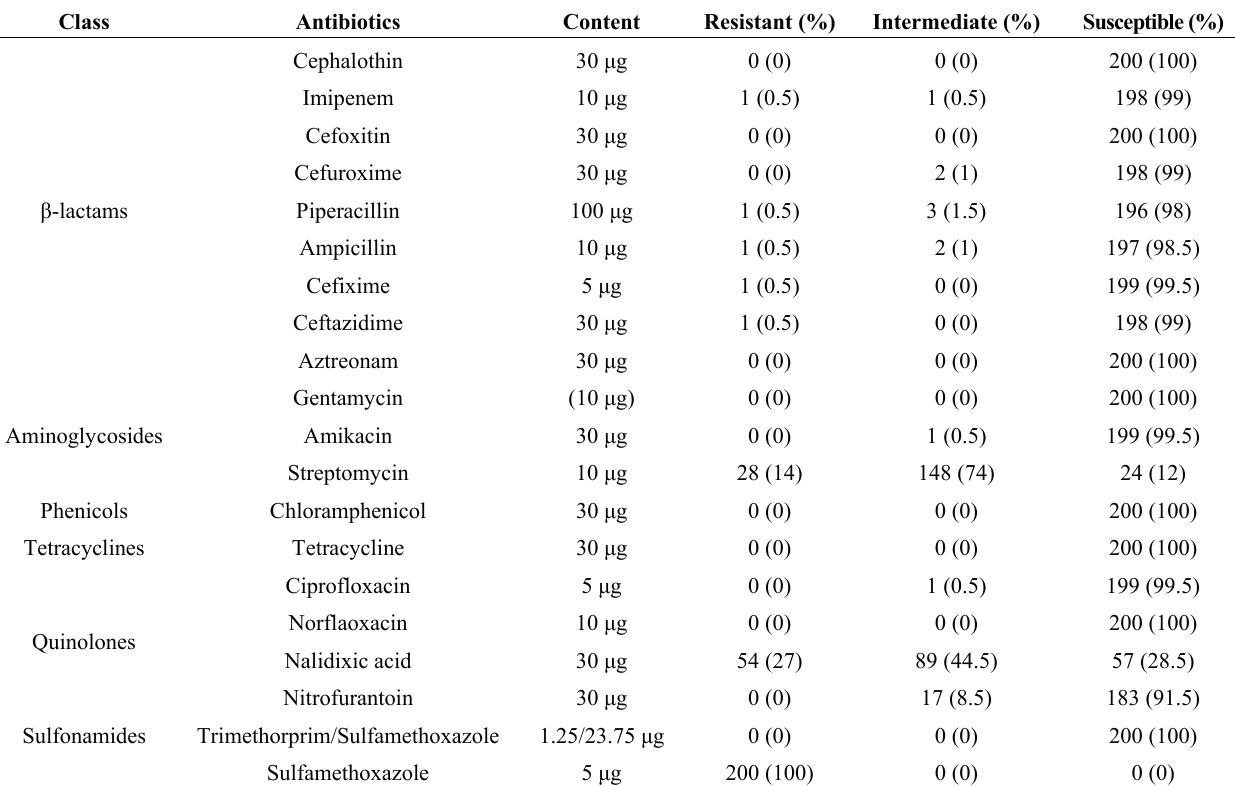
Table 6. Antibiotic resistance profile of Salmonella spp. recovered from wastewater treatment plants and receiving surface waters (n =